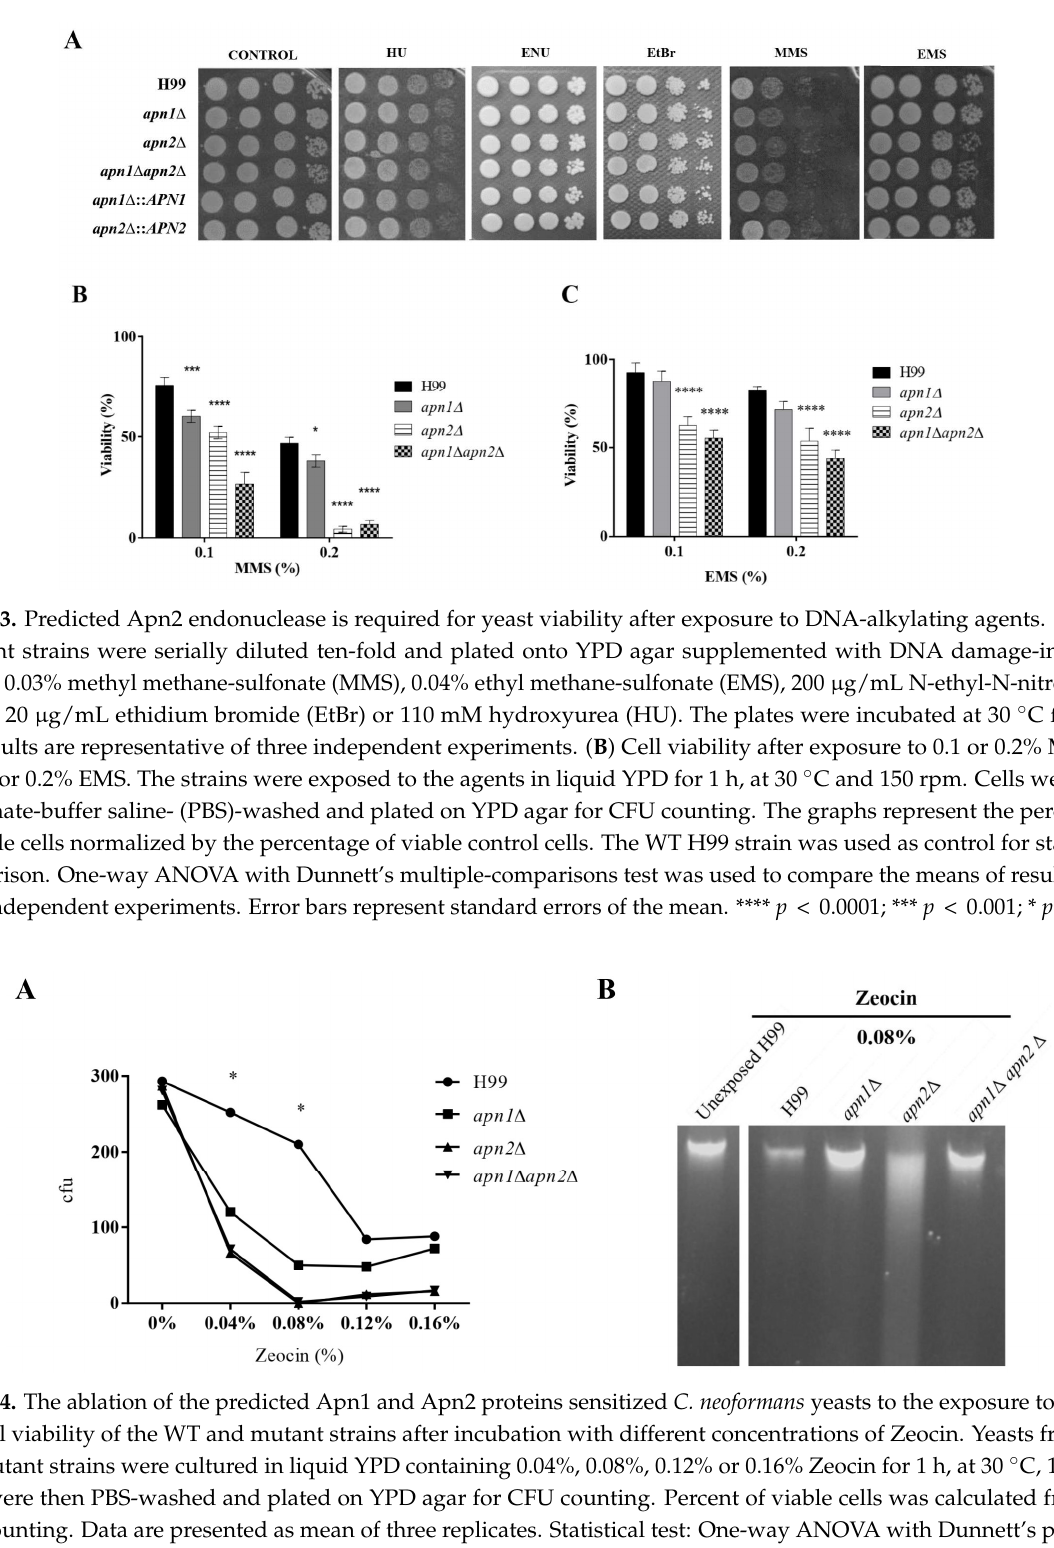
22 of 23 Figure 2. Disruption of Apn1- and Apn2-like genes induced C. neoformans susceptibility to UV radiation. ( A ) Ten-fold serial dilutions of C. neoformans WT, mutant and reconstituted strains of yeasts were exposed to 120, 240 and 480 J/m 2 doses of UV radiation (254 nm) and grown at 30 °C, for 48 h. The results are representative of at least three independent experiments. ( B ) Cell viability (%) after UV irradiation. C. neoformans 5 × 10 2 cells were plated on YPD agar and exposed to UV radiation at 120, 240 and 480 J/m 2 at 254 nm. The plates were incubated at 30 °C for 48 h, protected from light, for colony forming unit (CFU) counting. Graph represents the percentage of viable cells normalized by the percentage of viable control cells. The WT H99 strain was used as control for statistical comparison. One-way analysis of variance (ANOVA) with Dunnett’s post-test was used to compare the means of results from three independent experiments. Error bars represent standard errors of the mean. **** p < 0.0001. 3.4. The Putative Apn2 Endonuclease Is Involved in Processing Alkylation-Induced DNA Damage in C. neoformans In order to evaluate the possible roles of CnApn1 and CnApn2 predicted proteins in the repair of different types of DNA lesions, the growth of the mutant strains was evalu- ated after their exposure to different mutagenic agents. Neither the single mutant ( apn1 Δ